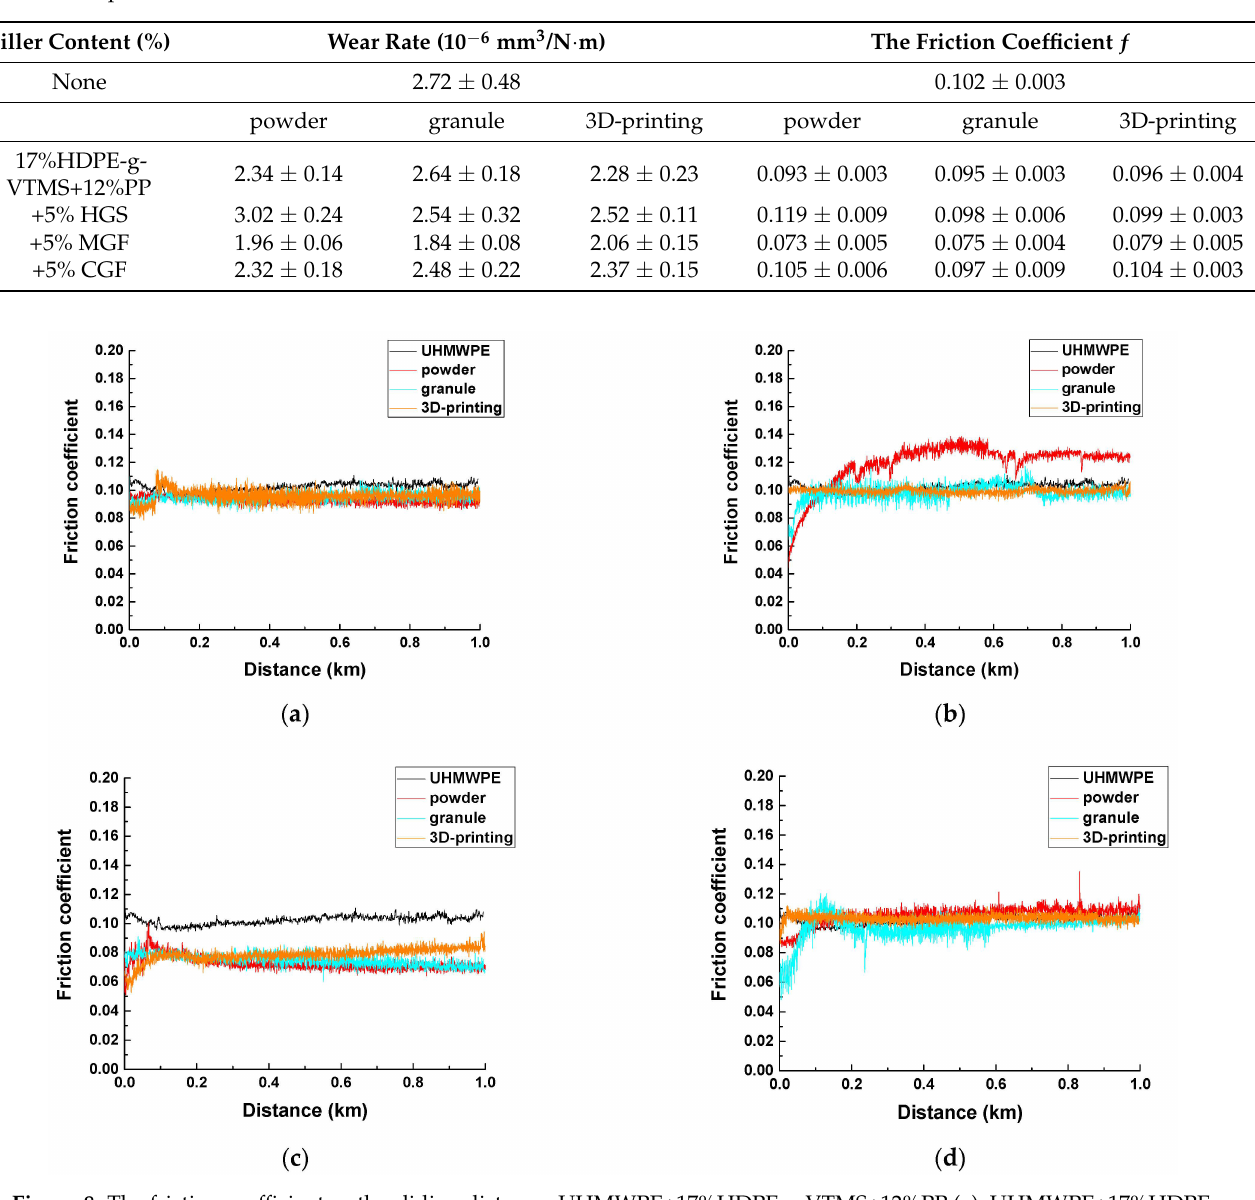
Figure 8. The friction coefficient vs the sliding distance: UHMWPE+17%HDPE-g-VTMS+12%PP ( a ), UHMWPE+17%HDPE- g-VTMS+12%PP+5%HGS ( b ), UHMWPE+17%HDPE-g-VTMS+12%PP+5%MGF ( c ), UHMWPE+17%HDPE-g- VTMS+12%PP+5%CGF ( d ). The ‘pin-on-disk’